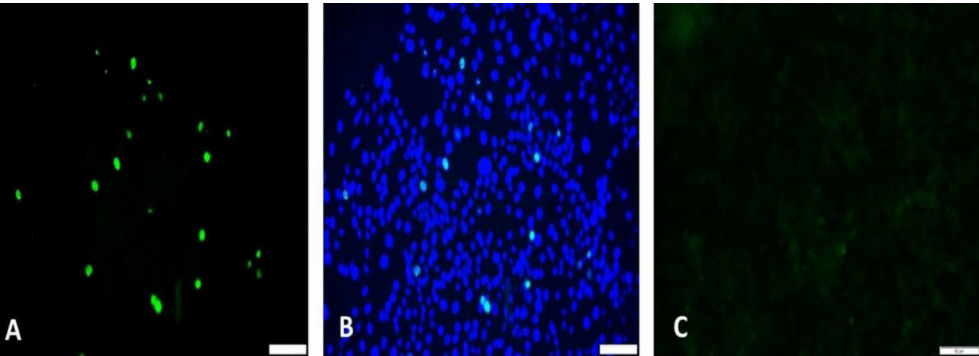
Figure 2. Detection of sPCV2-Vac in transfected cells: Rescue of the sPCV2 in PK-15 cells as detected by an immunofluores- cence assay with PCV2-specific polyclonal antibody. ( A )—Apple green nuclear fluorescence indicates PCV2 replication, ( B )—Overlay image with DAPI stained nuclei in blue. ( C )—Uninfected cell control. Bar—50 µ M